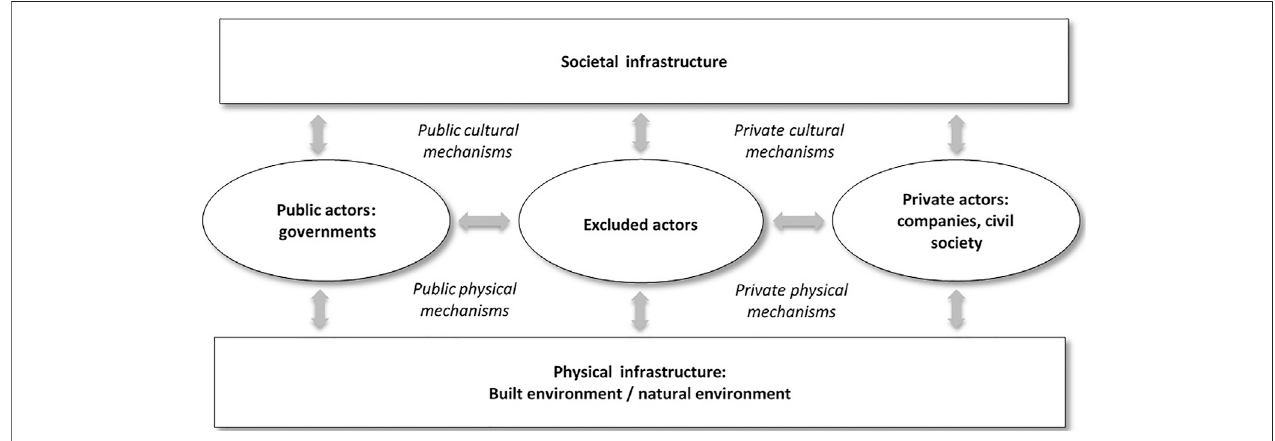
FIGURE 2 | Exclusion in a multi layered world: four